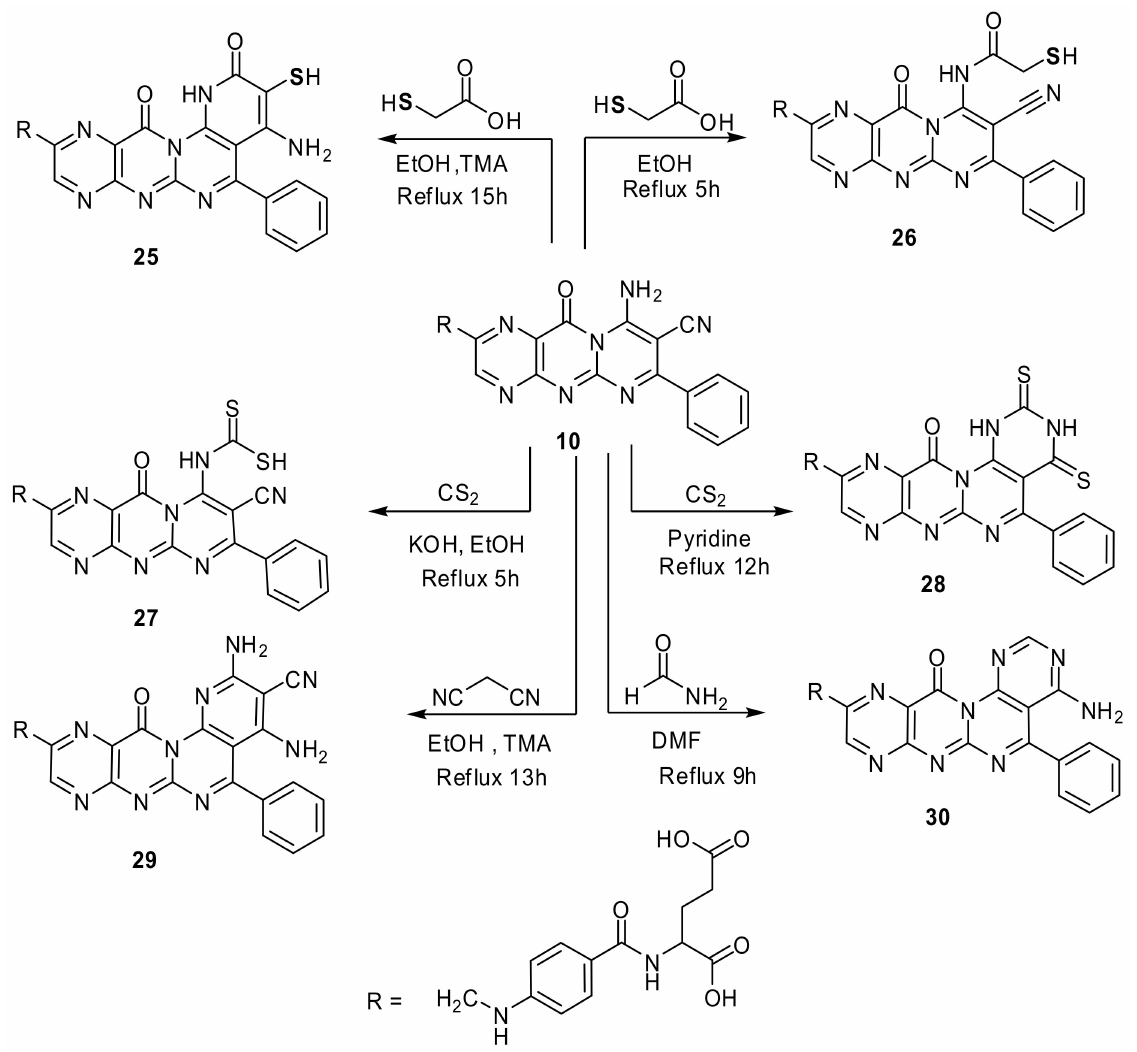
Scheme 5. Synthesis of some new fused systems on folic